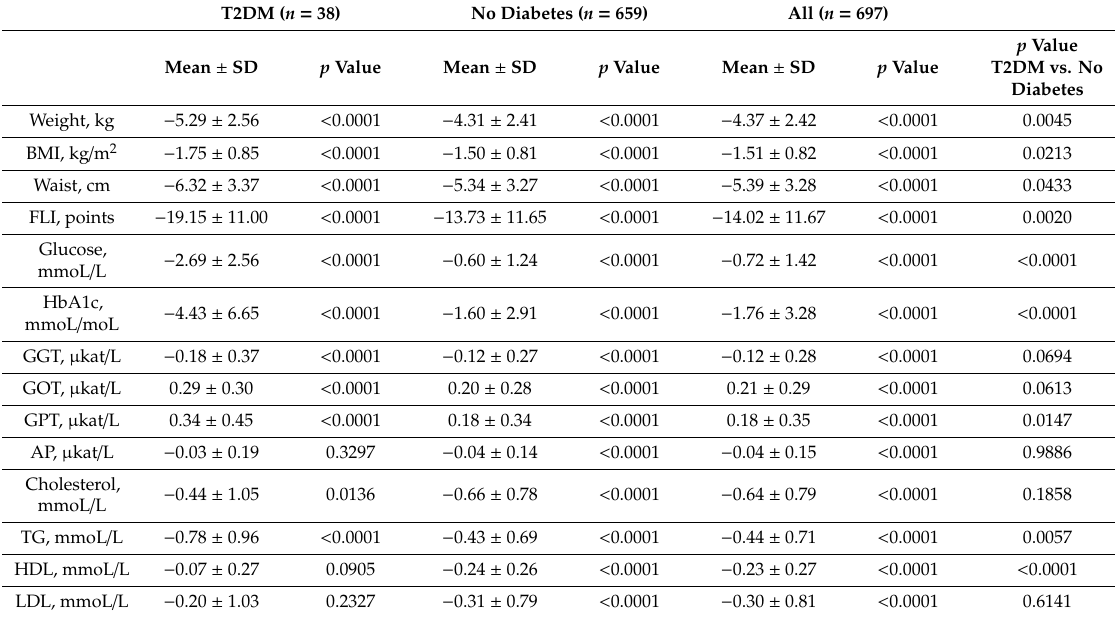
Table 2. Changes from baseline to post fasting, overall and for subjects with and without T2DM.